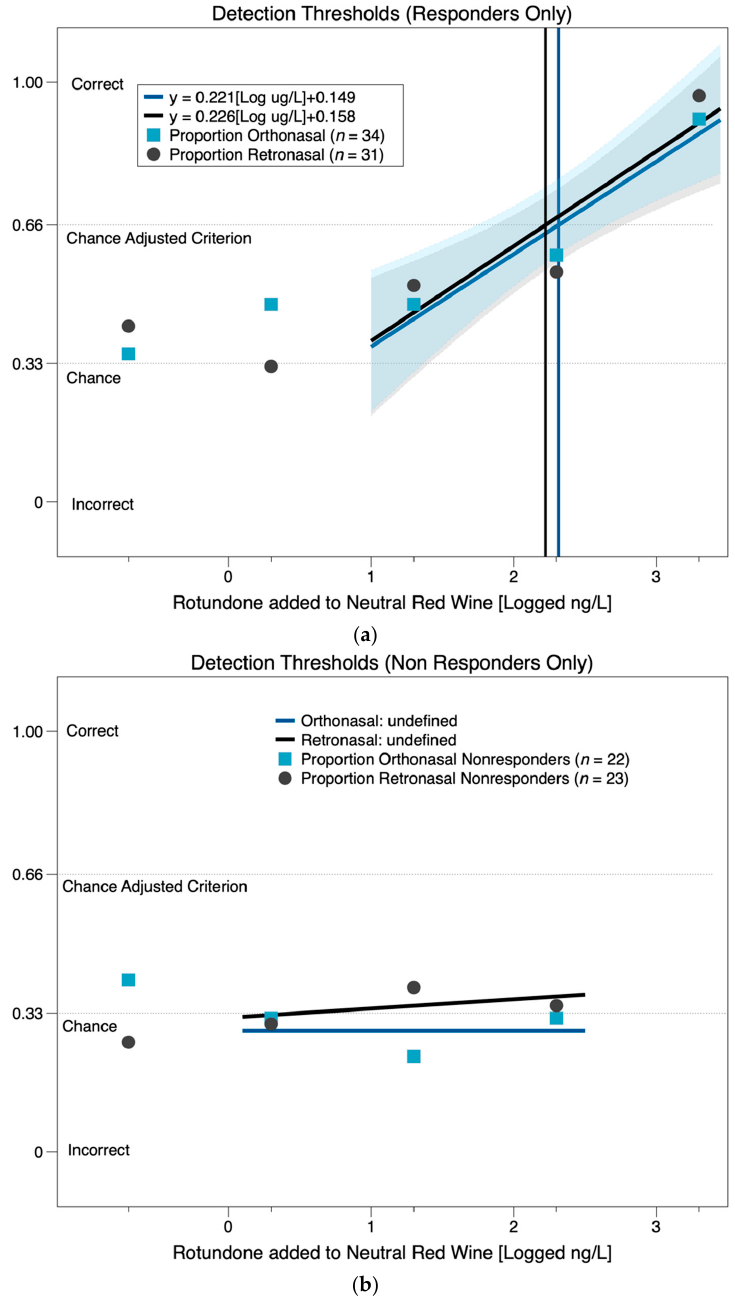
Figure 2. Estimated detection thresholds for rotundone in red wine using the graphical method, for responders ( a ) and non-responders ( b ) using the graphical method of [20], as modified by [21].